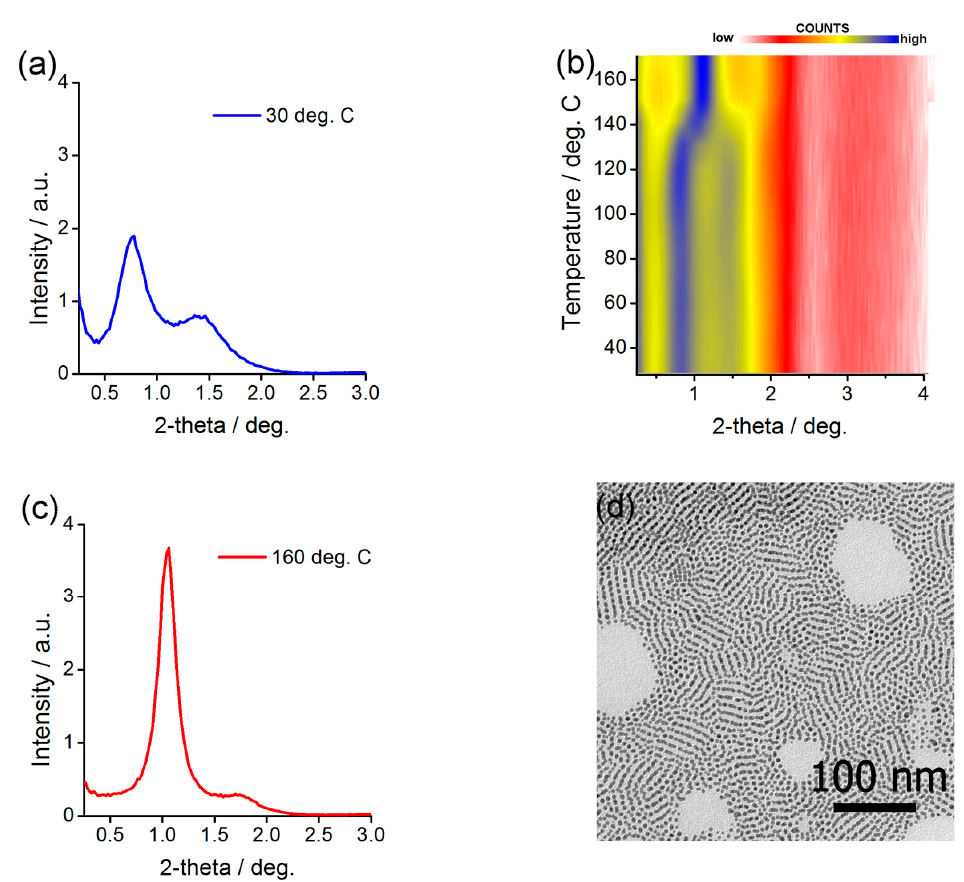
Figure 7. Structural investigation of Ag@L1/C11OH nanoparticles. ( a , c ) SAXRD profiles for low and high temperature structures (panels a, c, respectively) ( b ) Temperature evolution of SAXRD patterns taken for annealed sample and ( d ) corresponding TEM image.